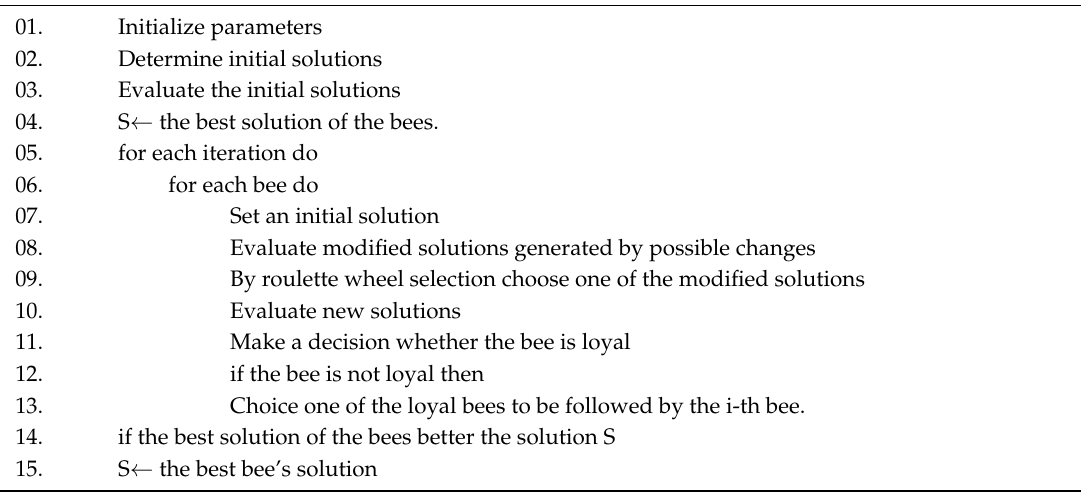
Algorithm 1. Bee Colony Optimization.